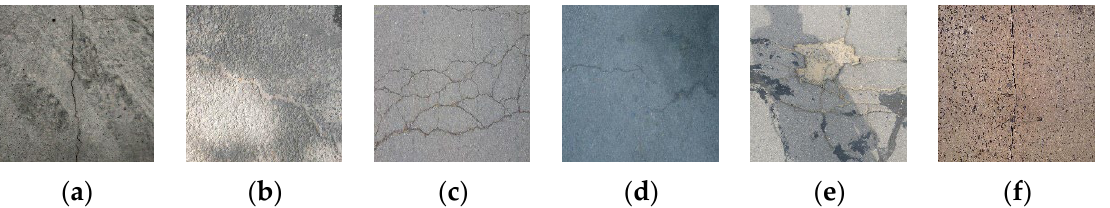
Figure 7. ( a ) Vertical crack with wheel print; ( b ) horizontal cracks with shadow interference; ( c ) mesh cracks; ( d ) cracks with water stains; ( e ) cracks with potholes; and ( f ) cracks in asphalt and gravel mixtures pavement.